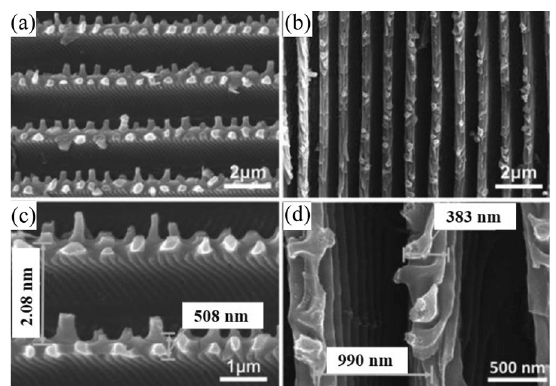
Figure 8 SEM image of bionic micro nano structure of Trogonoptera brookiana butterfly wings